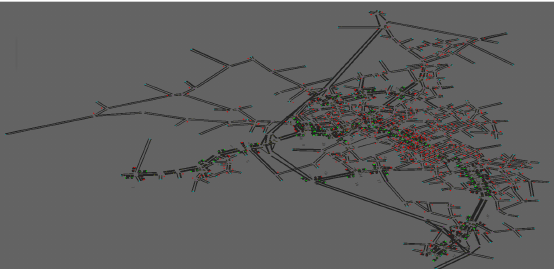
Figure 4. Blacksburg